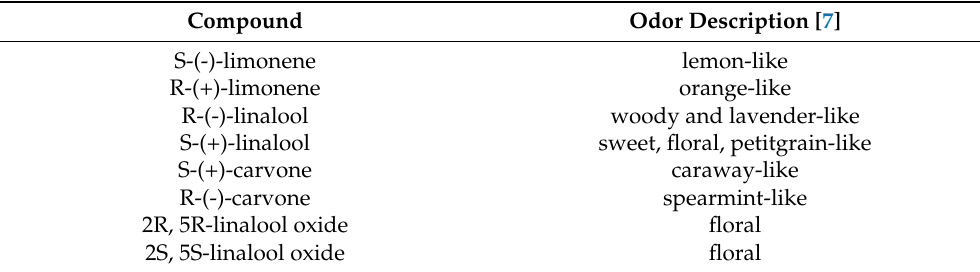
Table 1. Odor description of enantiomers identified in newly prepared fried pepper